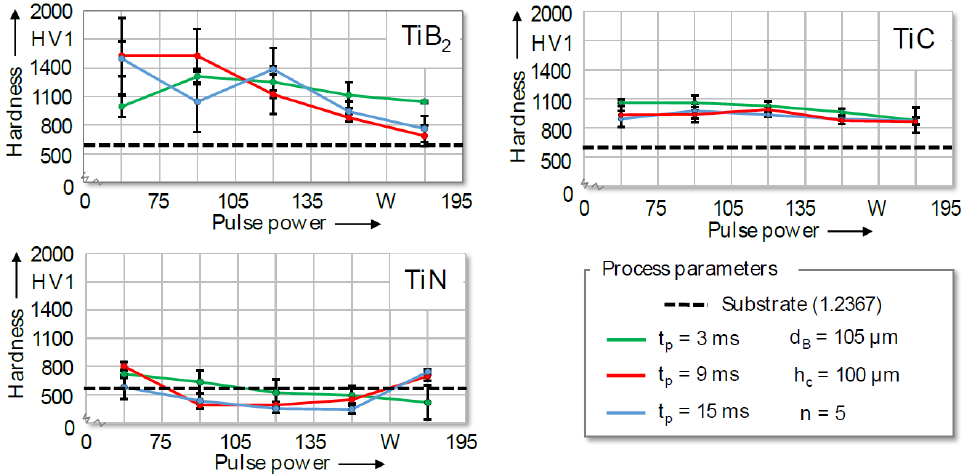
Figure 9. Measured hardness values in dependence on the applied pulse power and pulse duration.